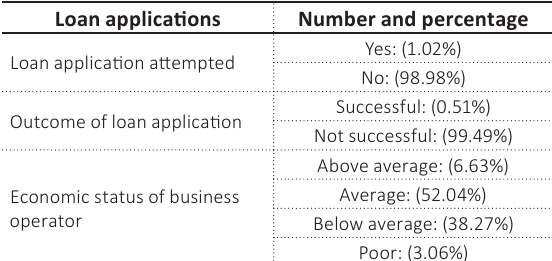
Figure 2. Number of years in business ( n = 196) Table 5. Loan applications by respondents ( n = 196)